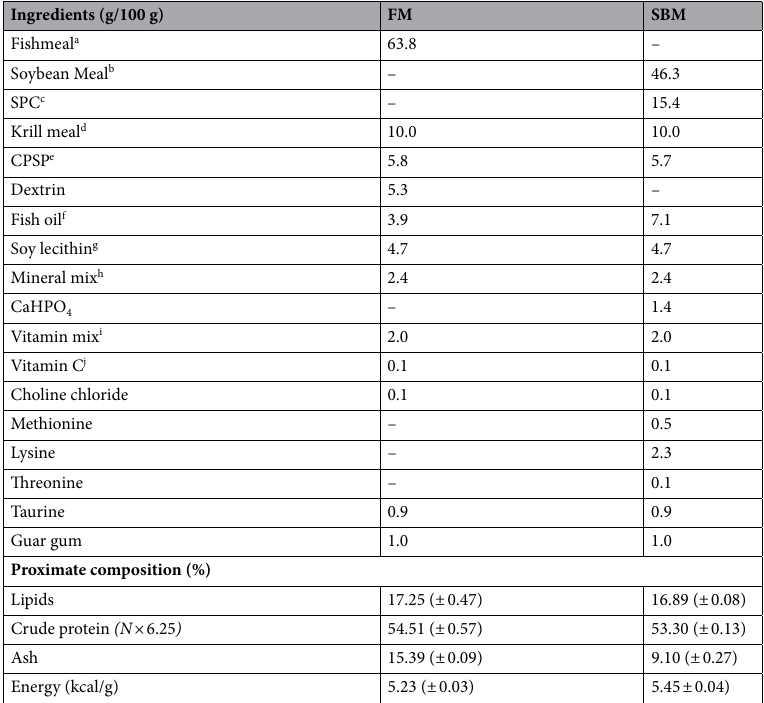
Table 1. Feed formulation of experimental diets. FM fishmeal, SBM soybean meal, SPC soy protein concentrate, CPSP fish protein hydrolysate. a Mechanically extracted menhaden meal, stabilized with 0.06% ethoxyquin (Omega Protein, Reedville, VA, USA). b Solvent extracted soybean meal (Premium Feeds, Perryville, MO, USA). c Crude protein concentration min. 92% (Dyets Inc, Bethlehem, PA, USA). d Proccesed Euphausia superba (Florida Aqua Farms, Dade City, FL, USA). e Soluble fish protein hydrolysate (Sopropeche S.A., Boulogne Sur Mer, France). f Cod liver oil (MP Biomedicals, Solon, OH, USA). g Yelkin TS lecithin (Ingredi Co., Baltimore, MD, USA). h Bernhart-Tomarelli mineral mix with 5 ppm selenium in a form